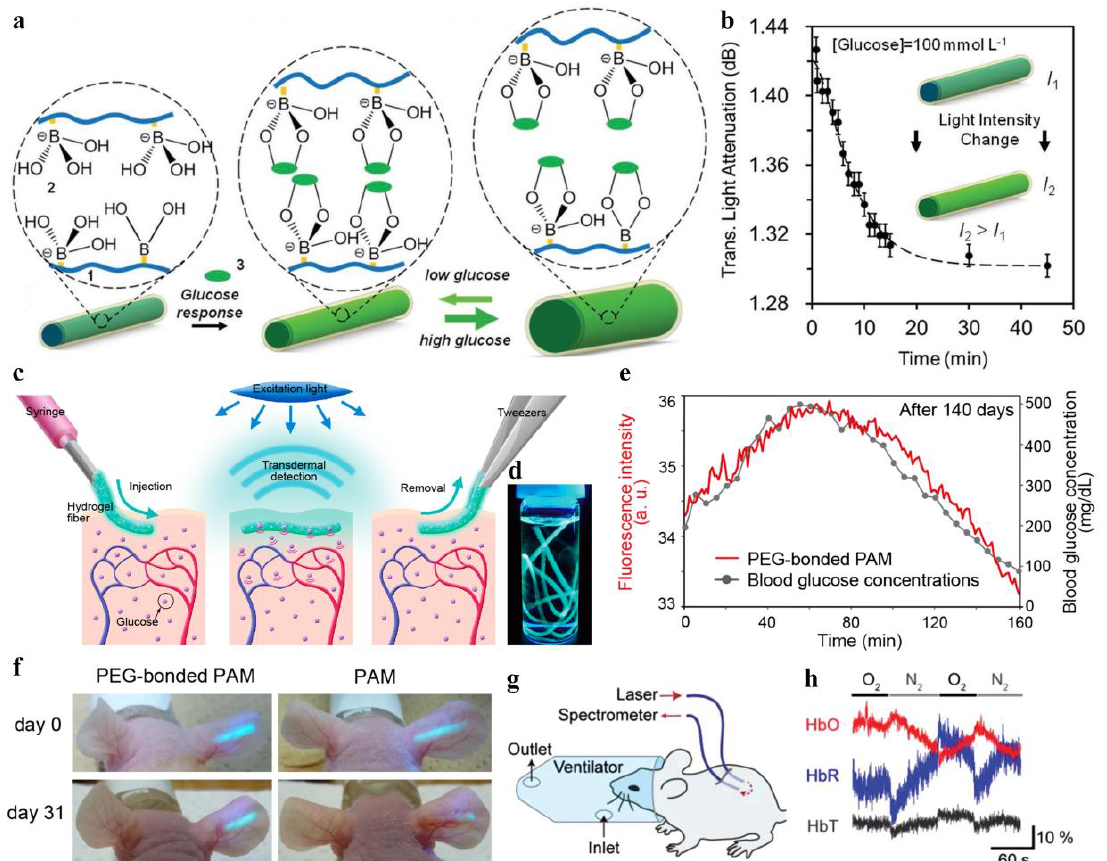
Figure 4. ( a ) Schematic diagram of a hydrogel optical fiber functionalized with 3-APBA for glucose monitoring. Reproduced with permission [40]. Copyright 2017, Wiley; ( b ) Intensity changes of the transmitted light through the glucose-sensitive fiber over time at a glucose concentration of 100 mmol L −1 . Reproduced with permission [40]. Copyright 2017, Wiley; ( c ) Injectable fiber incorporated with fluorescent glucose-responsive monomer for long-term monitoring of blood glucose concentration in vivo. Reproduced with permission [73]. Copyright 2011, National Academy of Sciences; ( d ) Photograph of fluorescent fibers in a glass vial. Reproduced with permission [73]. Copyright 2011, National Academy of Sciences; ( e,f ) Implantation of fluorescent fibers in the ear of mice for glucose monitoring. Reproduced with permission [73]. Copyright 2011, National Academy of Sciences; ( g,h ) Two core-cladding hydrogel optical fibers implanted in mouse subcutaneous tissue